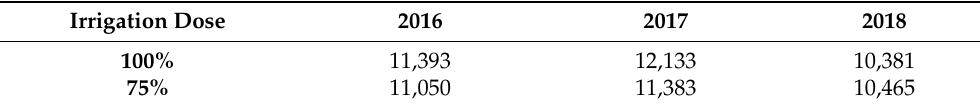
Table 5. Maize production (kg ha − 1 ) in each season according to the irrigation dose. Irrigation Dose